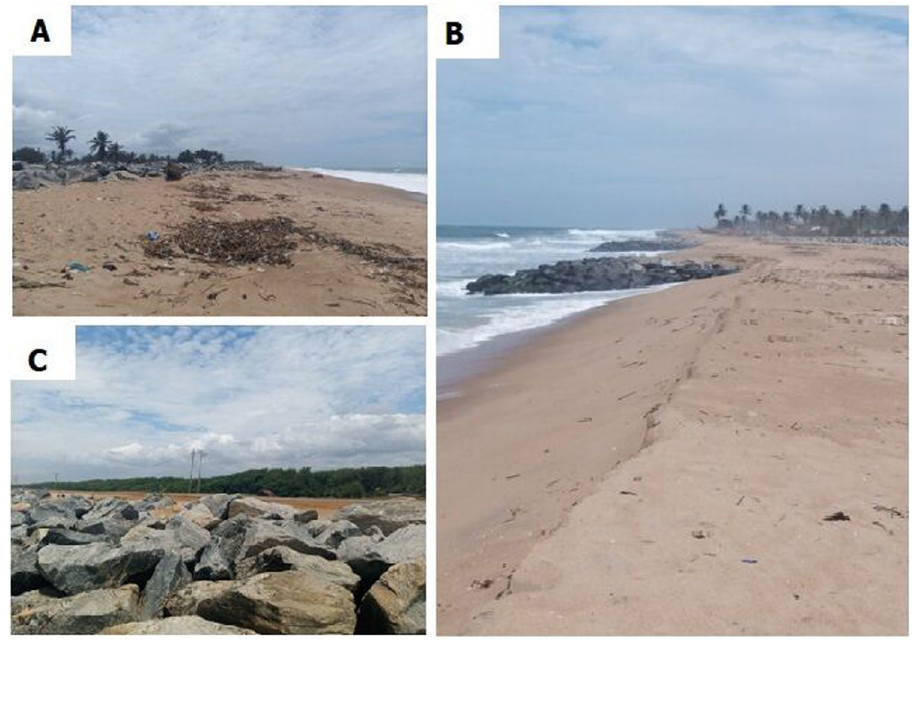
Fig. 7 A Revetments con- structed along the coast at Akplowotorkor. B Series of groynes constructed along the Dzita and Ada East coast. C Large Armour rocks con- structed along the coast of Atorkor